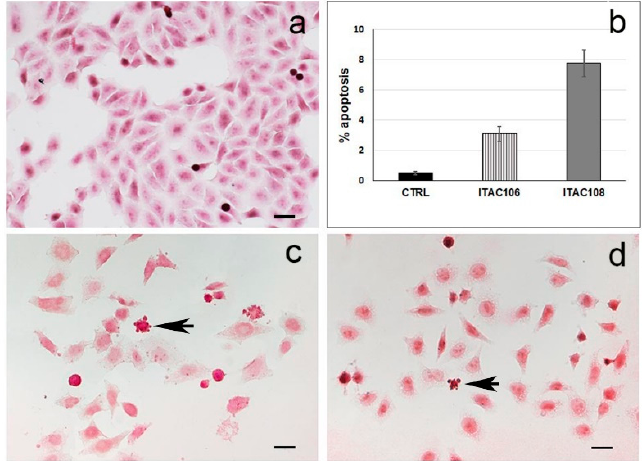
Figure 4. HeLa cells treated with cyanobacteria aqueous cell supernatants. ( a ) control; ( b ) percentage (%)